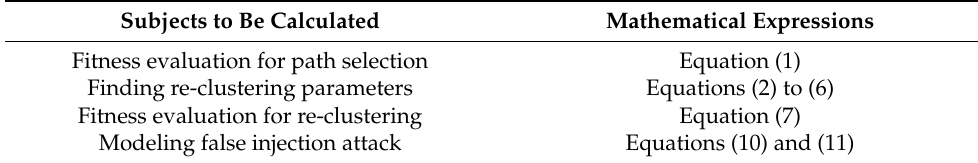
Table 3. Calculations involved in simulation